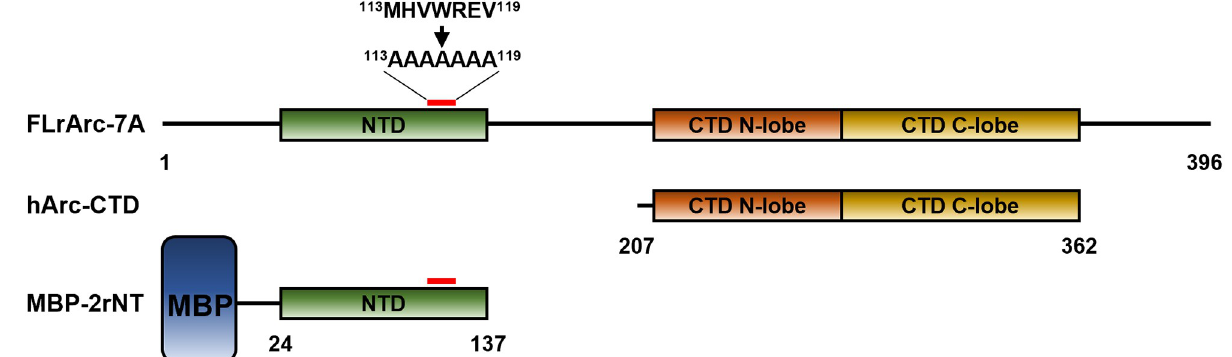
Fig 1. The Arc constructs used in this study. FLrArc-7A is full-length rArc (residues 1–397) with residues 113–119 mutated to Ala to hinder capsid formation [18]. hArc-CTD contains residues 207–362. Not shown is the N-terminal 6xHis-tag and the linker containing the TEV site. 2rNT is the NTD of rArc (residues 24–137) with the poly-Ala mutation. The domain was insoluble in the absence of its fusion partner, maltose binding protein (MBP). FLhArc corresponds to FLrArc-7A, but with the human Arc sequence without any